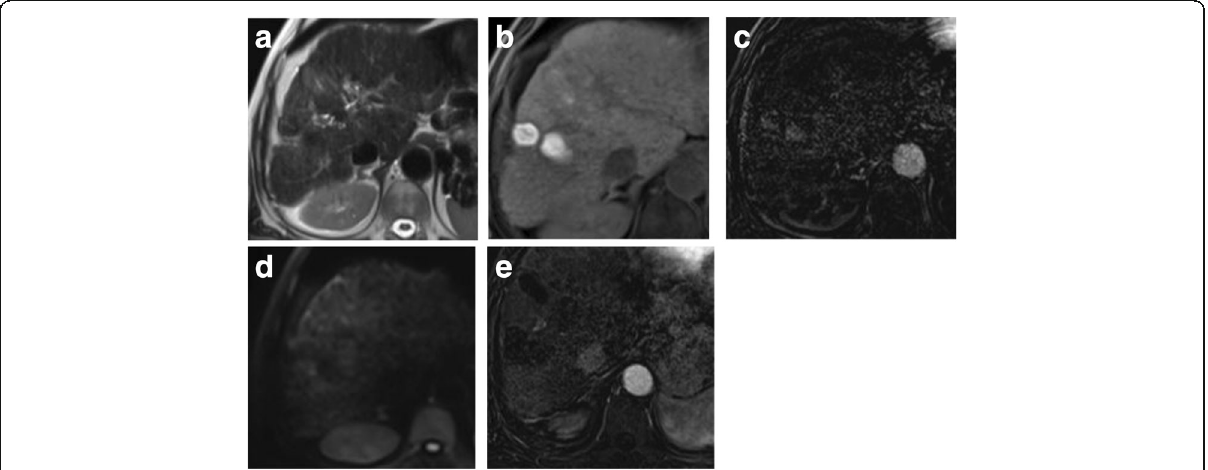
Fig. 12 Two hepatic focal lesions after old RFA. a T2-WI shows a hypointense signal of the treated focal lesions. b Pre-contrast T1 fat-suppressed image shows the ablated HFLs with their bright signal due to coagulative necrosis. c Subtracted T1-WI arterial phase shows newly developed faint enhancement of the lesions. d DWI shows no true restriction corresponding to the enhancement. e Subtracted T1-WI arterial phase after a 3-month interval shows no enhancement of the lesions. Initial post-treatment assessment by LI-RADS v2018 is LR-TR equivocal that proved to be nonviable after a short-interval follow-up. DWI was consistent with LR-TR nonviable from the start with no restriction initially and on the follow- up (not